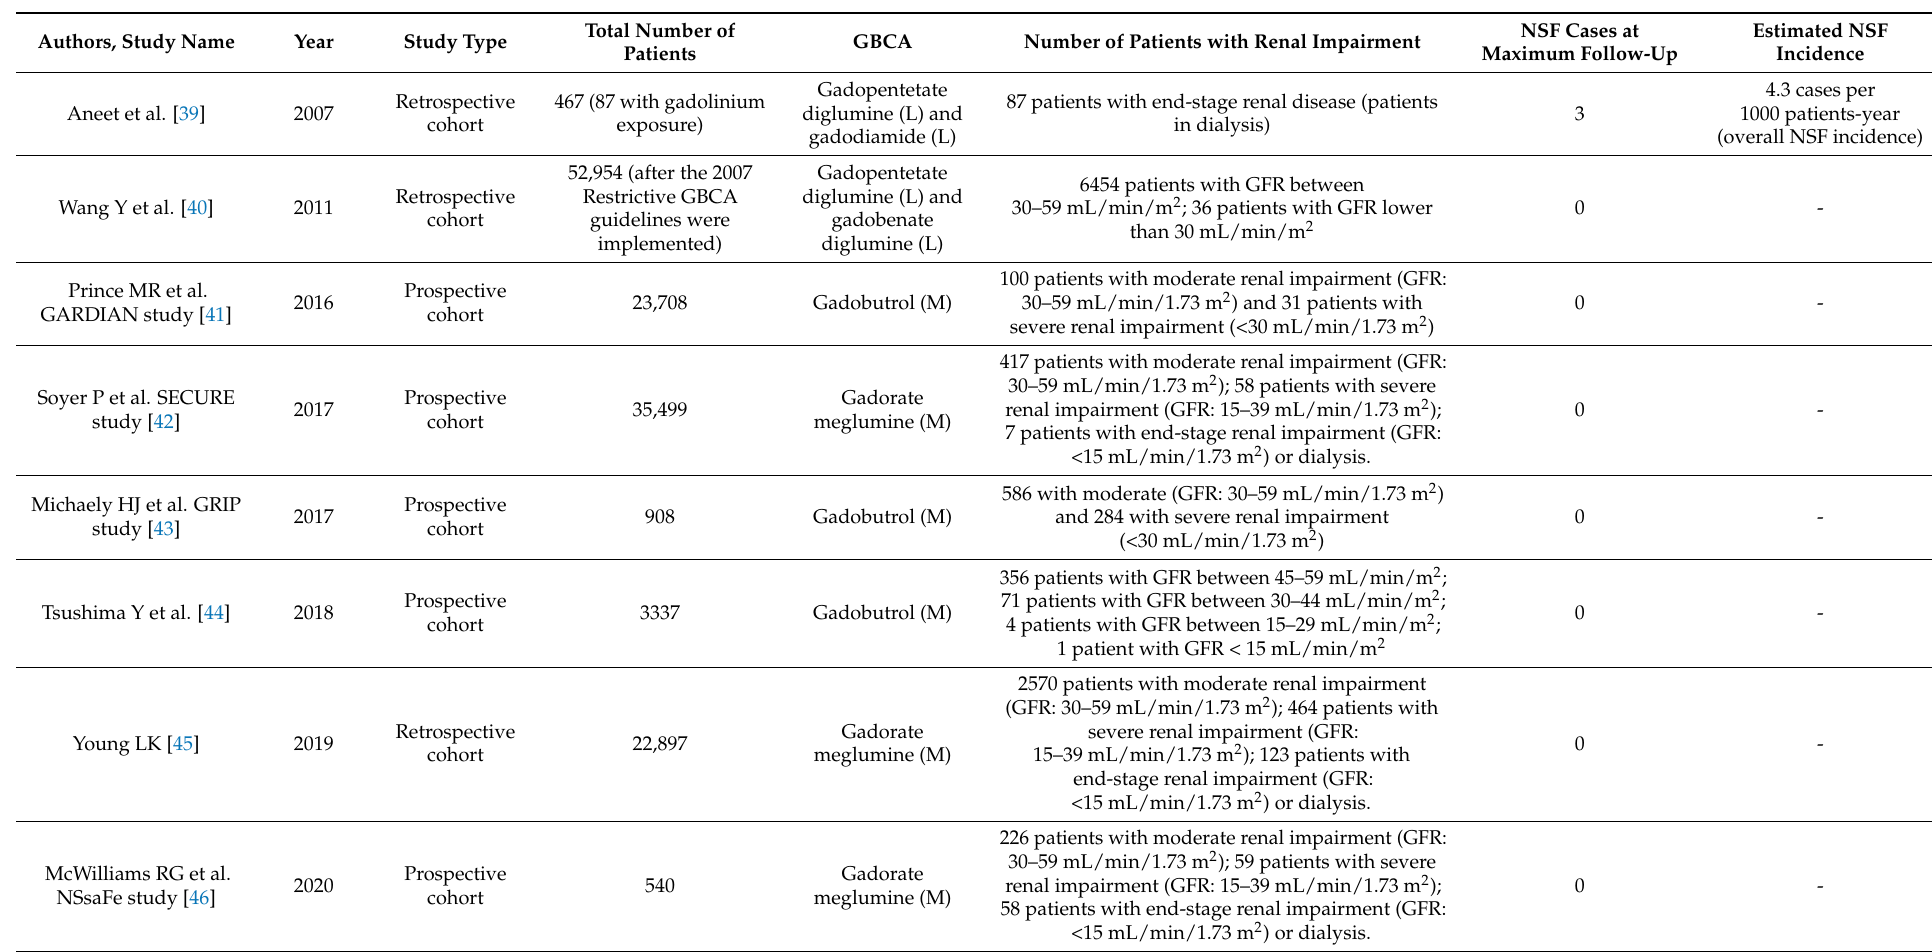
Table 5. Safety and tolerability studies of M-GBCAs and